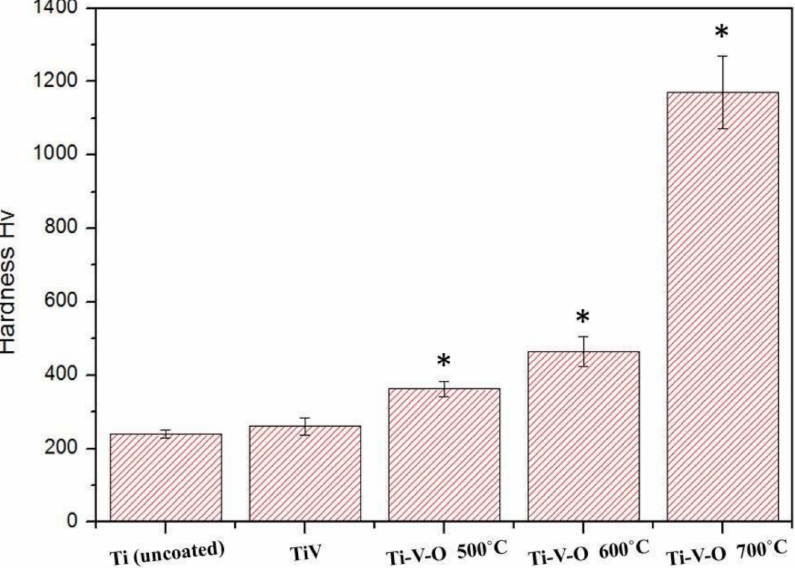
Figure 4. Vickers hardness test results of the uncoated Ti, TiV coating, and HTA Ti-V-O coating samples. * Significantly different from the control group—uncoated Ti plate ( p <